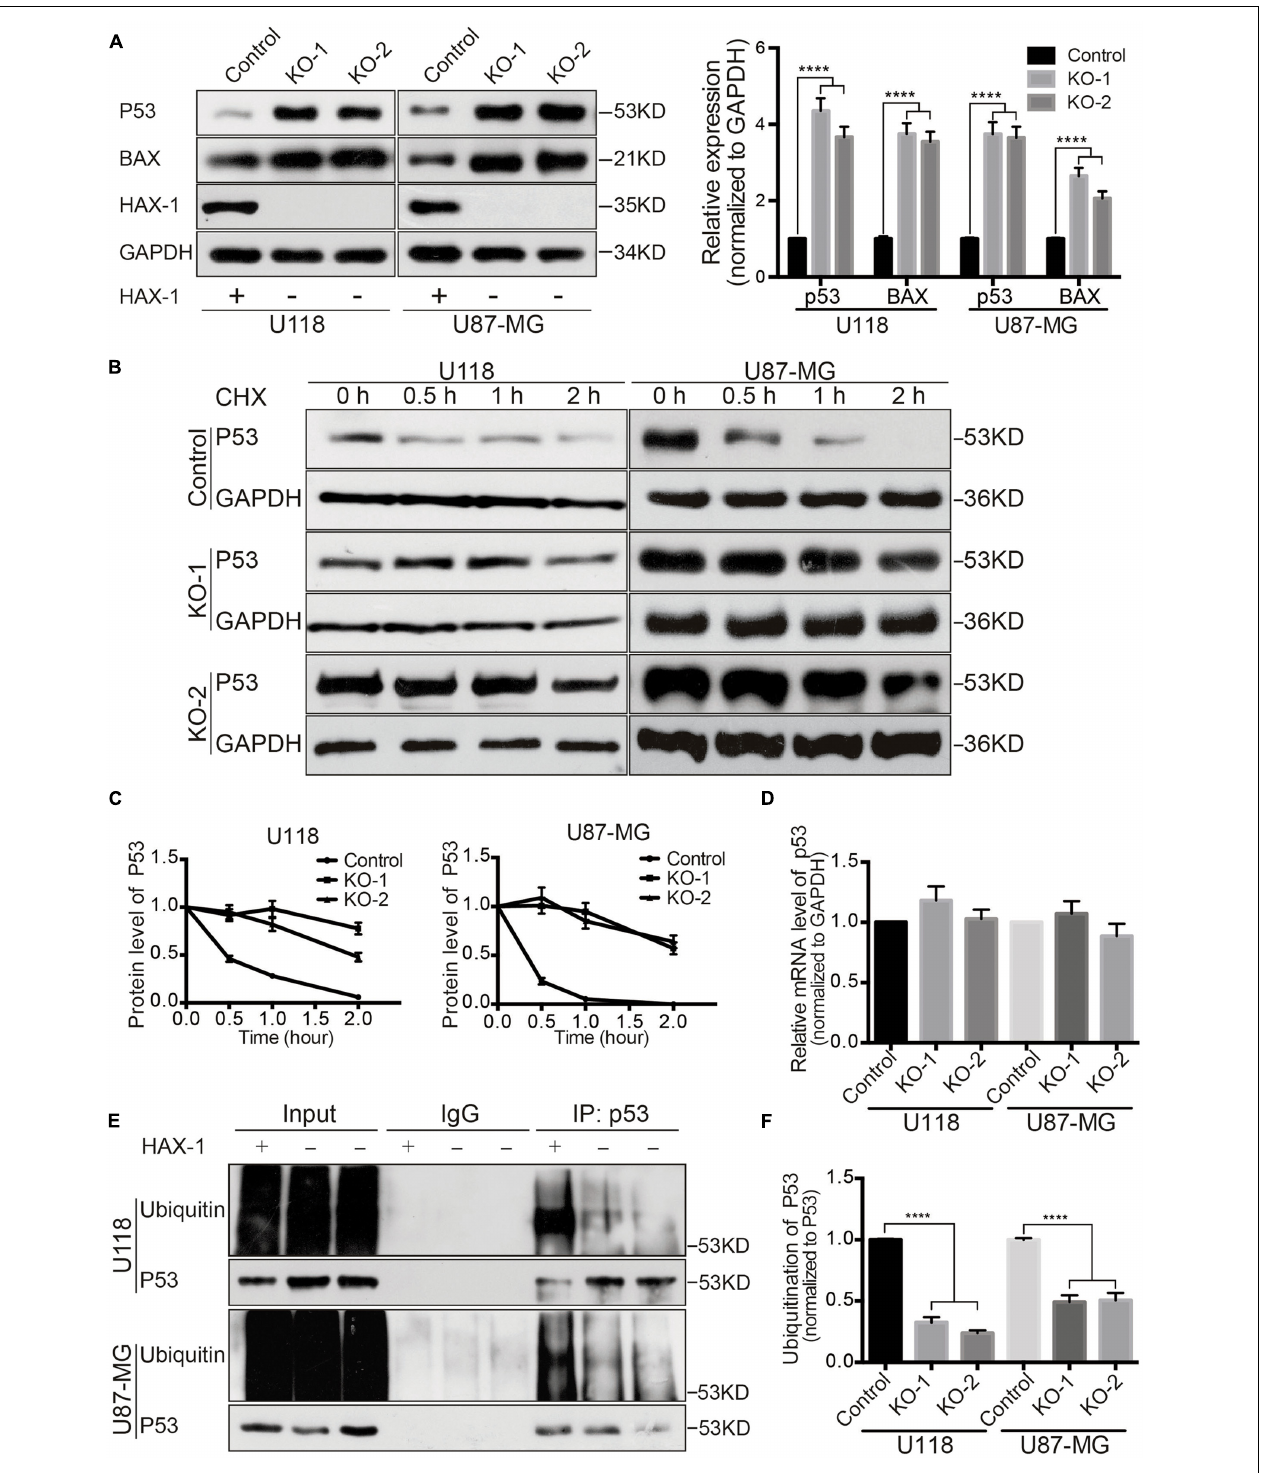
FIGURE 5 | HAX-1 is involved in the regulation of the degradation of p53 protein. (A) HAX-1 knock-out enhanced the expression of p53 and Bax. GAPDH was used as a loading control. (B,C) Western-blot showed the degradation rate was slowed down in the absence of HAX-1. GAPDH was used as a loading control. (D) qRT-PCR indicated the level of p53 mRNA did not alter with the expression of HAX-1. GAPDH was used as a loading control. (E,F) The ubiquitination of p53 was reduced in HAX-1 knock-out U118 and U87-MG cells. P53 was used as a loading control. Three individual experiments were performed for each group. ∗∗∗∗ P <